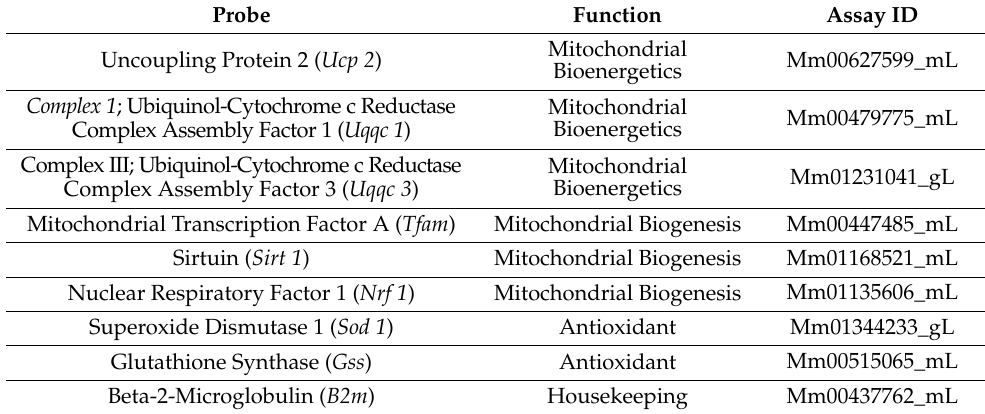
Table 1. The list of TaqMan probes used in the